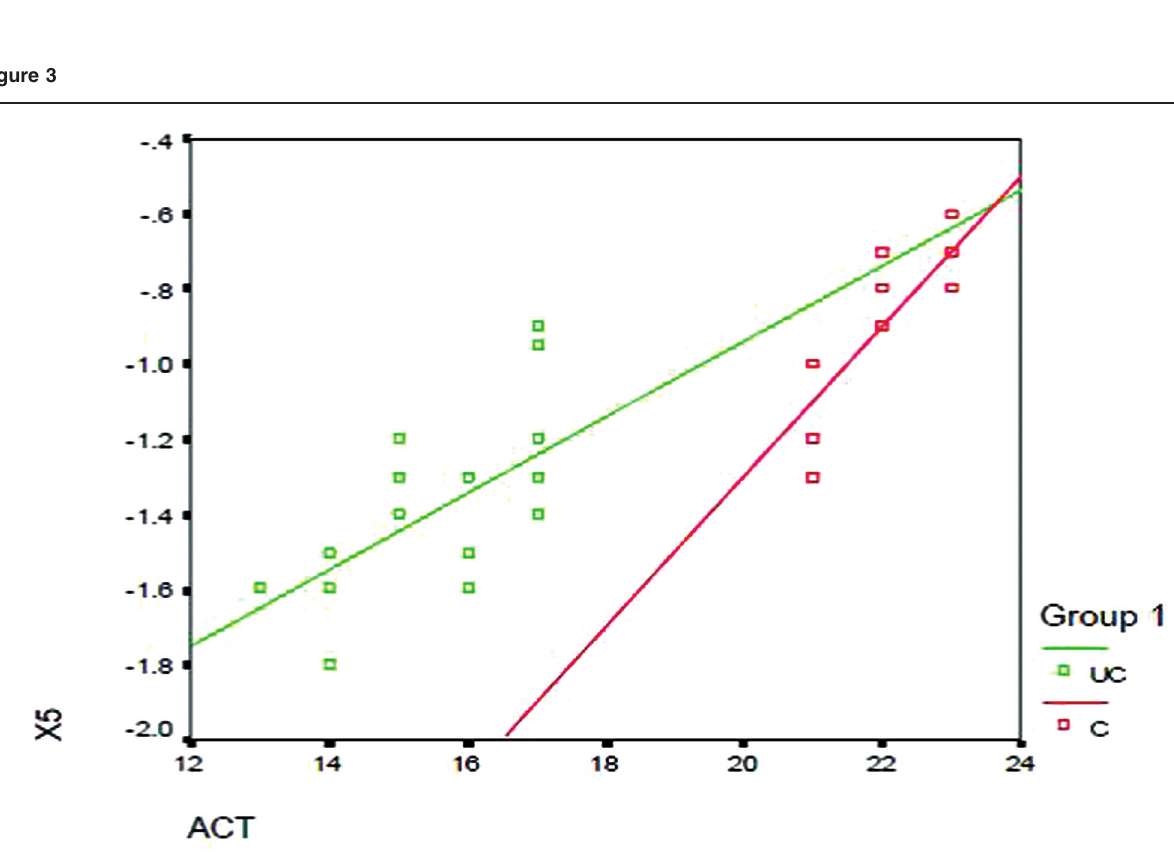
Correlation between X5 and asthma control test in both